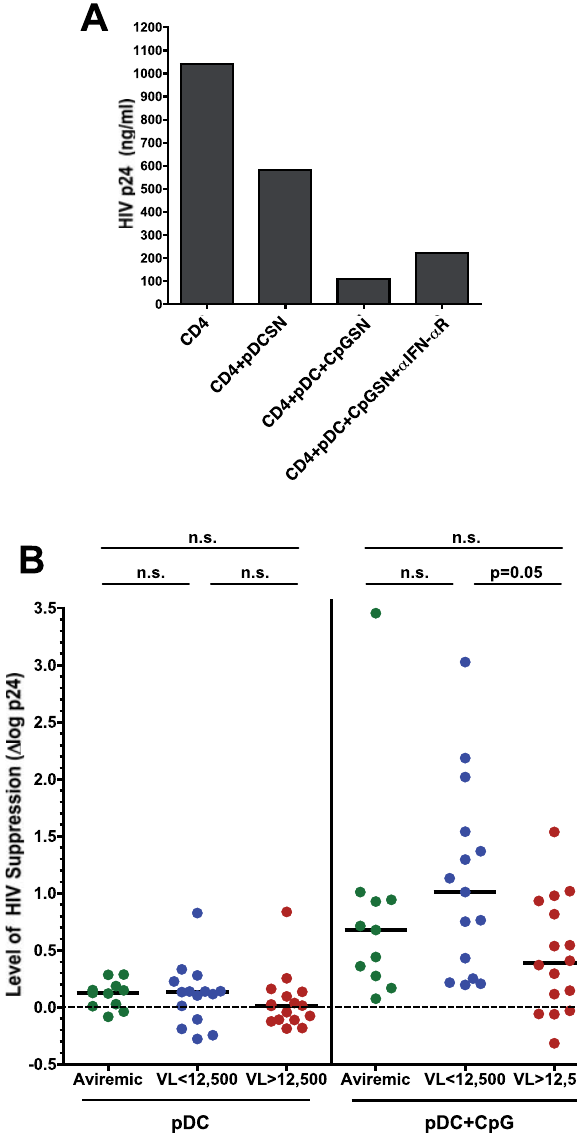
Figure 3. Soluble factor-mediated suppression of HIV replication. HIV p24 assays were set up as in Figure 2, with the exception that pDCs were cultured at 5 6 10 4 cells/well separately from CD4 + T cells, and supernatants from unstimulated or CpG ODN 2216-stimulated pDC cultures were added to the T cells at days 0, 3, and 5. Data from day 7 are shown. A) A representative example of data from a viremic patient. B) Effect of soluble factors secreted by pDCs on HIV replication in autologous CD4 + T cells, expressed as in Figure 2. Data are shown for supernatants from unstimulated pDCs (left panel) and CpG-stimulated pDCs (right panel). Data are expressed as delta log p24 as described above. n.s., not significant.